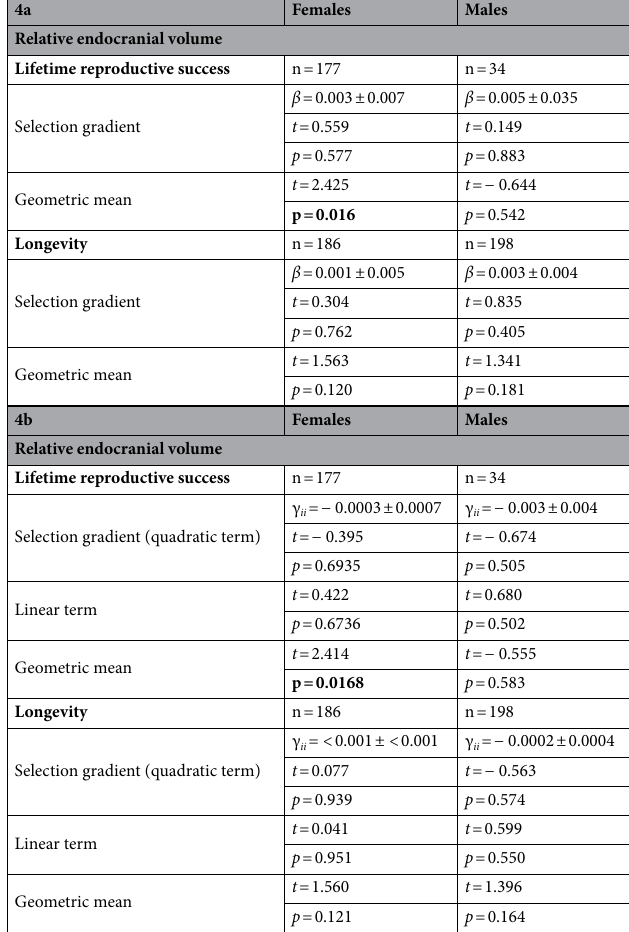
Table 4. Linear (4a) and quadratic (4b) selection gradients (GLMs) for relative endocranial volume in females and males. Selection gradients are the estimate ± the standard error. Statistical significance (p < 0.05) is indicated in bold. β indicates the linear selection gradient, γ ii the quadratic selection gradient, t the t-value, and p the